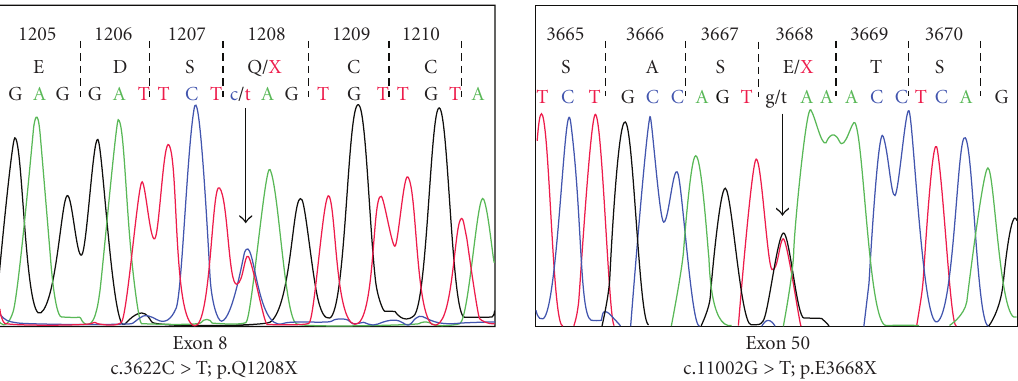
Figure 5: Two heterozygous nonsense mutations in the CHD1 gene in our patient; p.Q1208X in exon 8 and p.E3668X in exon